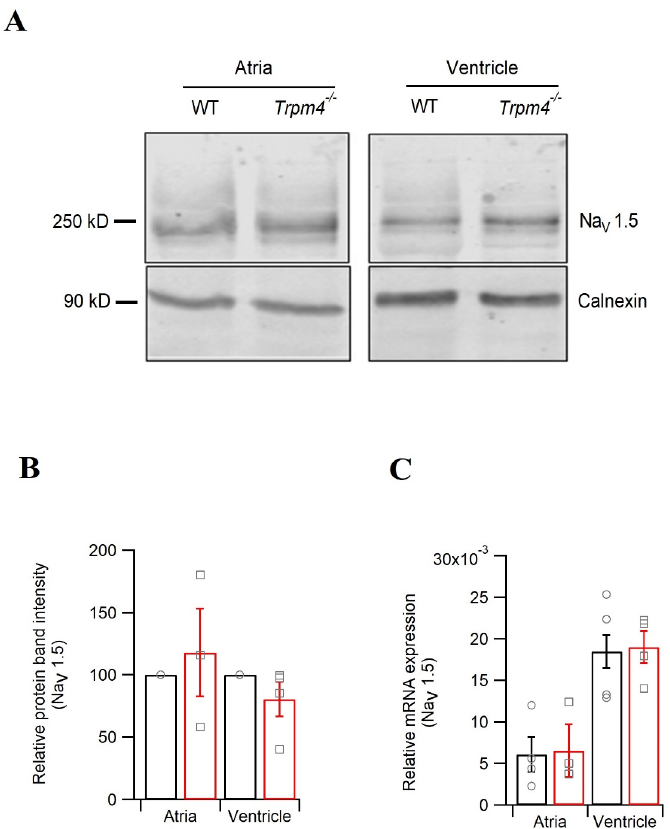
Figure 6. Expression of Na v 1.5 in mouse atria and ventricles. ( A ) Representative immunoblots showing Na v 1.5 expression from atria and ventricles, either from WT or Trpm4 − / − mice. ( B ) Quantification of the immunoblots showing the total Na v 1.5 expression in atria ( N = 6; p = 0.63) and ventricles ( N = 13; p = 0.20): WT (circle, black) or Trpm4 − / − (square, red). ( C ) Na v 1.5 mRNA quantification using RT-qPCR from atrial and ventricular tissue; WT (circle, black) or Trpm4 − / − (square, red). The Ct values were corrected with GAPDH ( N = 4; p = 0.87 and 0.89 for atria and ventricles, respectively).